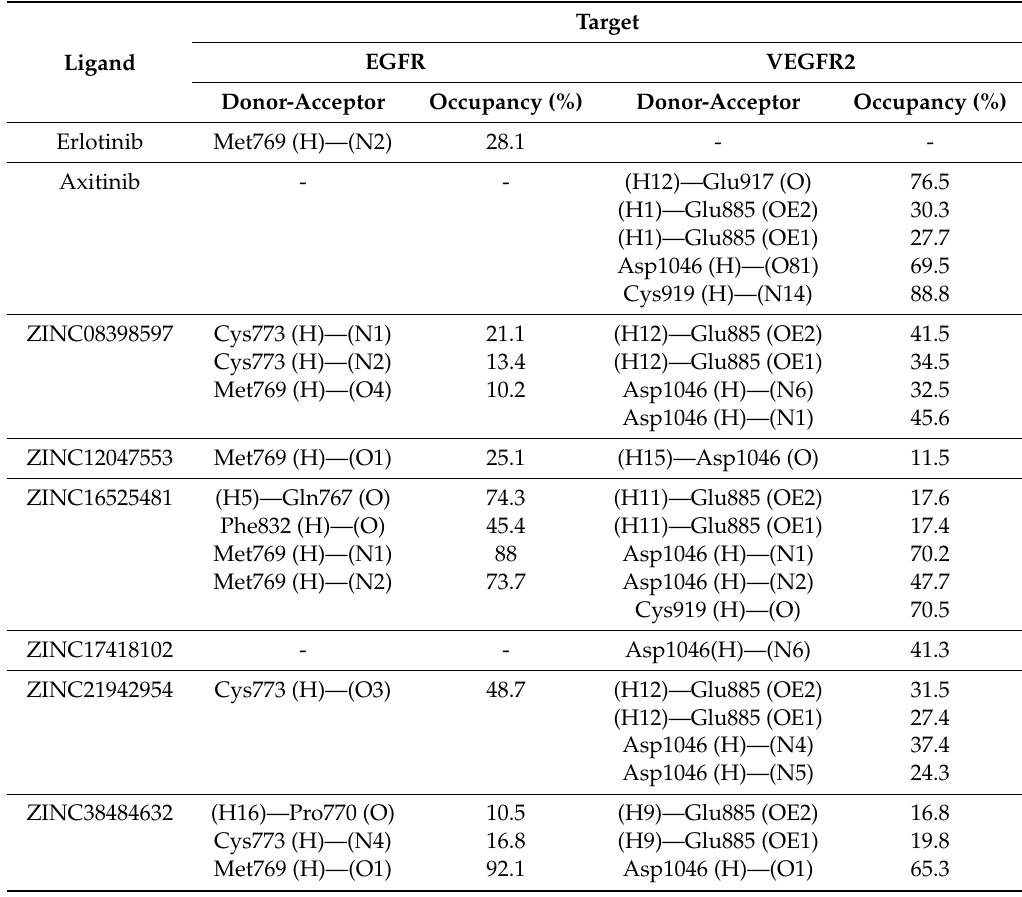
Table 3. Occupancy of hydrogen bond during 50 ns